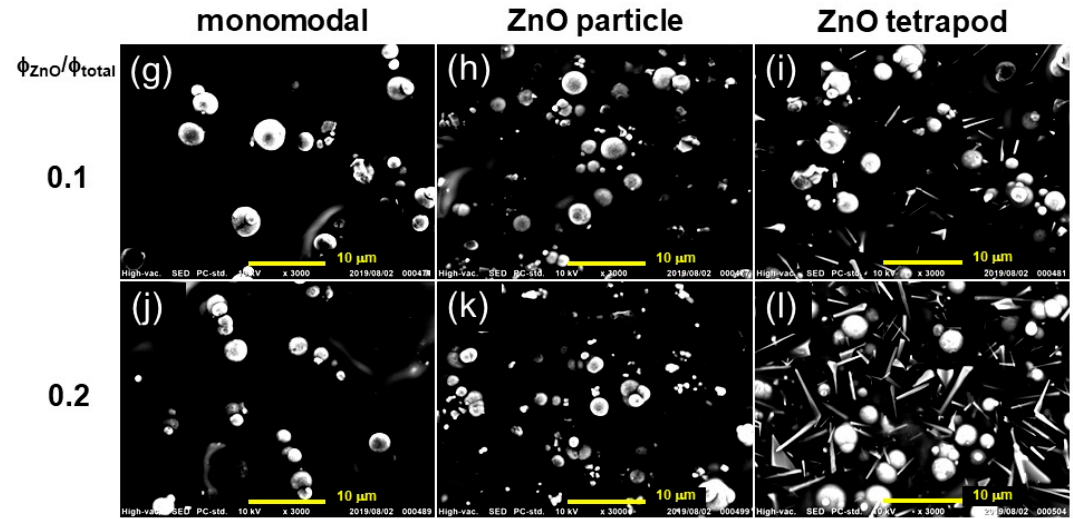
Figure 6. SEM photographs for ( a , d , g , j ) monomodal magnetic elastomers, ( b , e , h , k ) bimodal magnetic elastomers with nonmagnetic particles and ( c , f , i , l ) bimodal magnetic elastomers with nonmagnetic tetrapods at substitution ratios of φ ZnO / φ total = 0.1 and 0.2. Magnification ( a – f ) × 1500 and ( g – l ) × 3000.